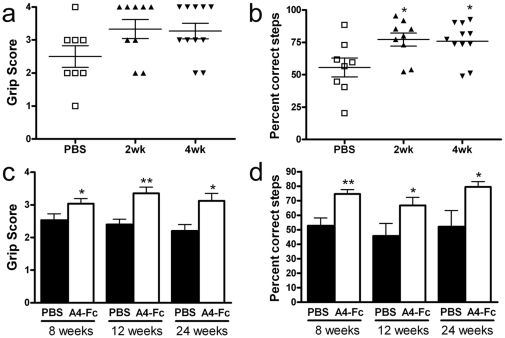
Prolonged treatment with EphA4-Fc and extended recovery.(A, B) To determine whether extending treatment length to 4 weeks promoted greater functional improvement EphA4-Fc was administered for 2 weeks or 4 weeks, after which (A) grasp score and (B) grid climbing accuracy were assessed at 6 weeks post-injury. Both the 2-week and 4-week treatments improved functional outcomes compared to controls, but were not significantly different to each other. (C, D). To determine whether extending the recovery period for longer than 6 weeks would allow further functional improvement, animals were treated with EphA4-Fc for 2 weeks after injury and assessed at 8, 12 and 24 weeks. Analysis of (C) grasp score and (D) grid climbing accuracy showed that no further improvements were observed after 8 weeks in control or treated mice. (mean±SEM, *p<0.05, **p<0.01).